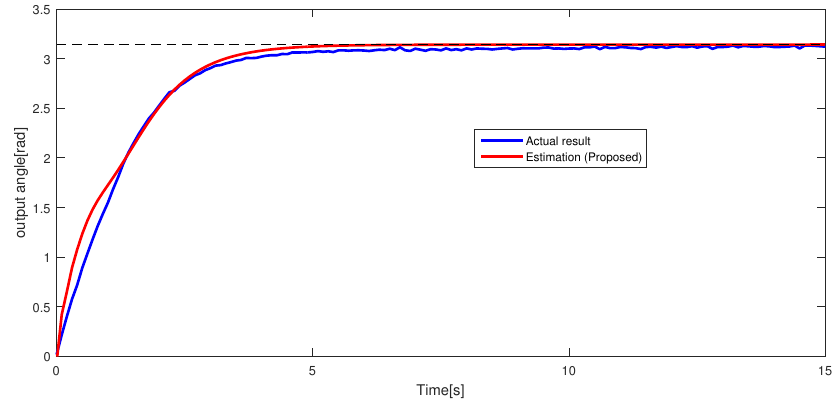
Figure 11. The result of the proposed